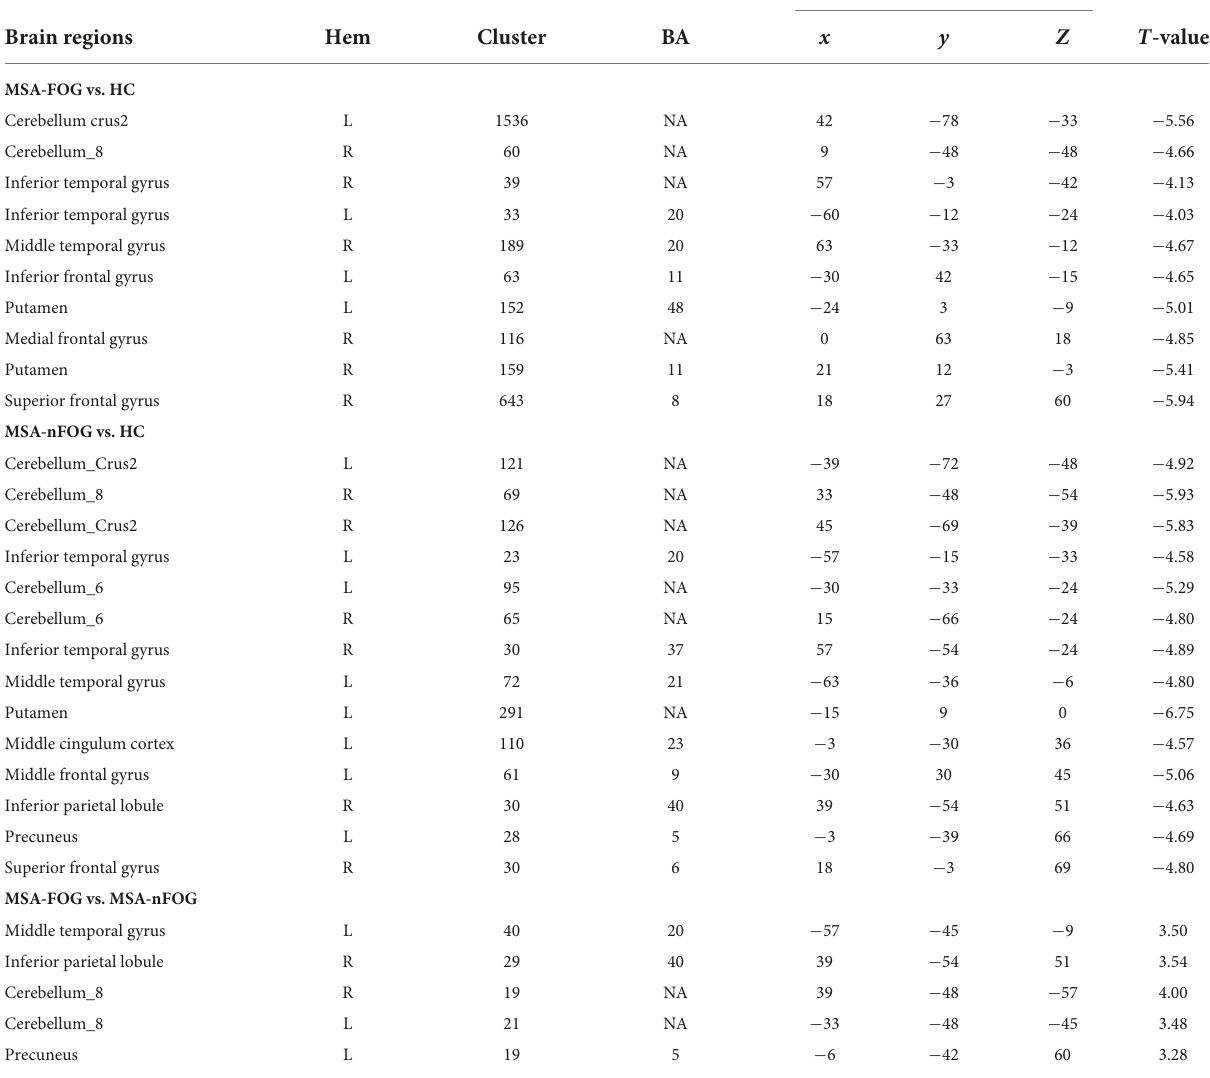
TABLE 3 Brain area differences in right thalamus dominated FC network between patients with MSA and